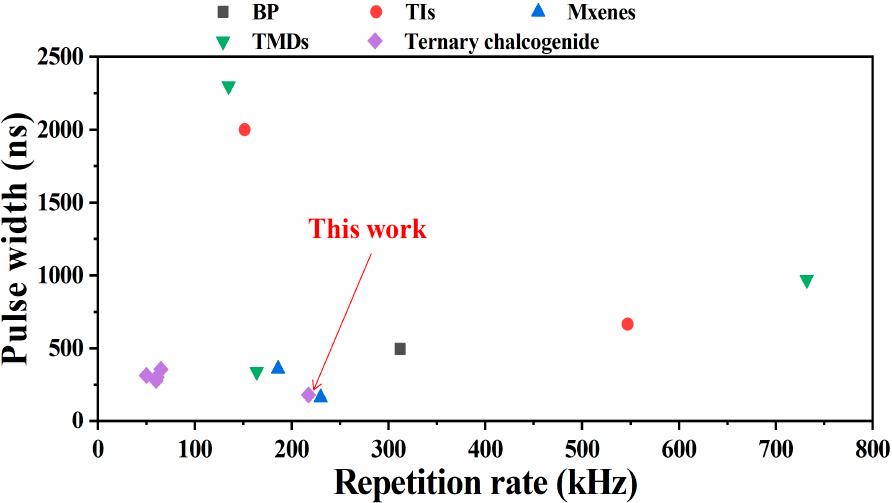
Figure 7. Pulse width versus repetition rate of PQS solid-state lasers based on different new 2D materials.